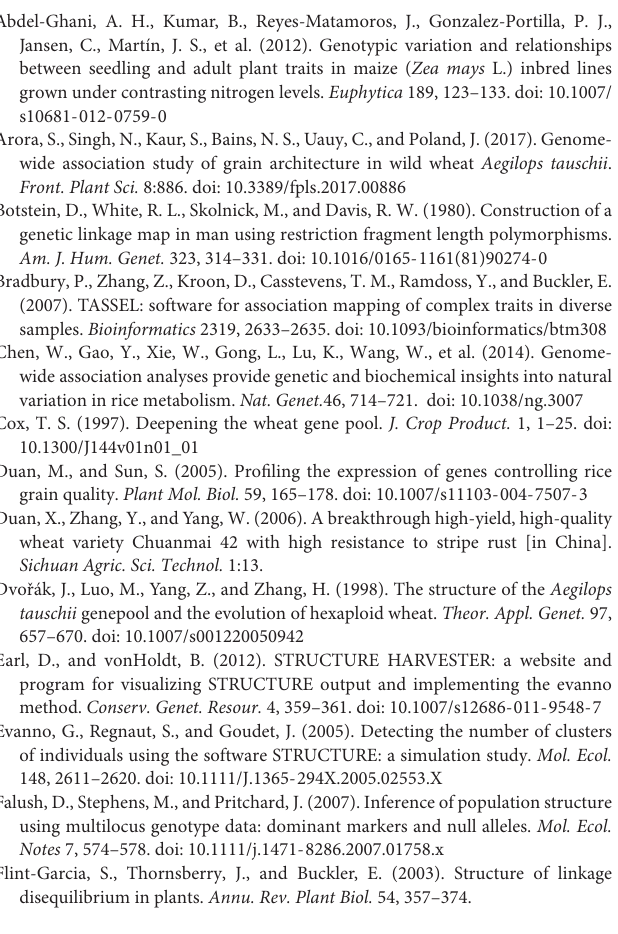
Supplementary Figure 1 | The distribution of 6723 SNP markers on seven chromosomes of Aegilops tauschii .